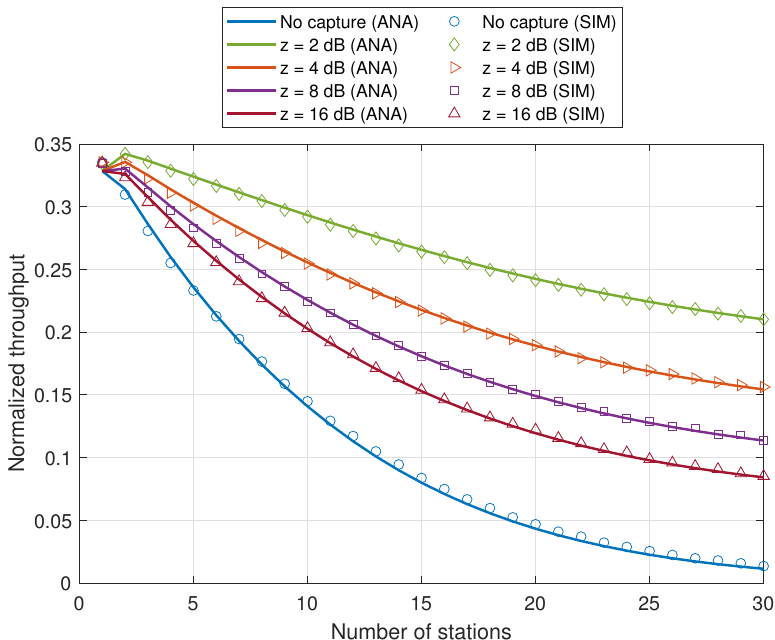
Figure 11. Impact of the capture threshold on the RAW slot